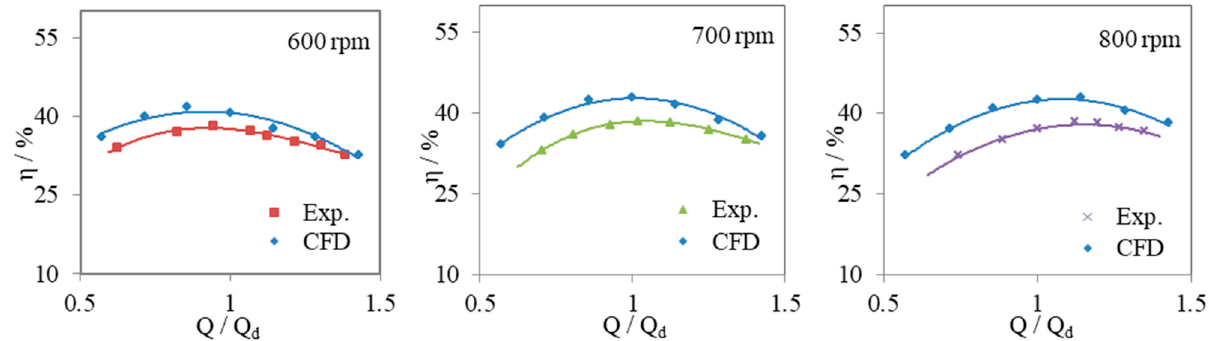
Figure 5. The efficiency in the experiment and the numerical calculation.